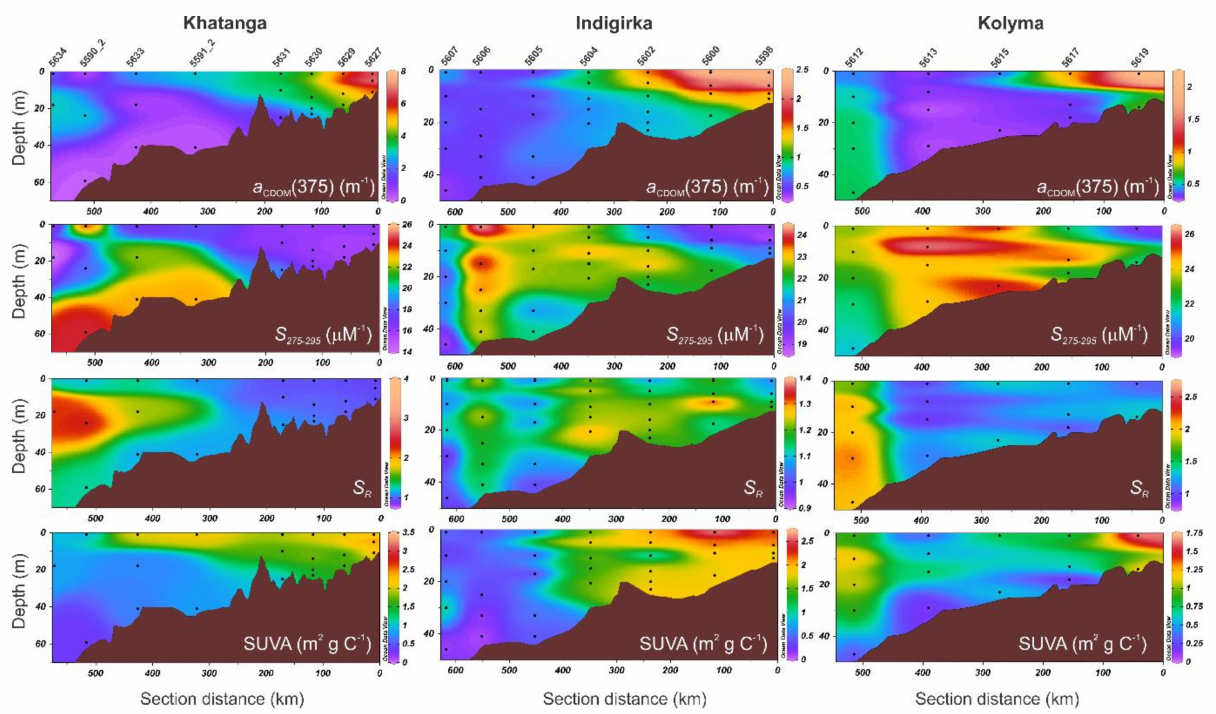
Figure 7. Distribution of a CDOM (375), S 275–295 , S R and SUVA along the Khatanga, Indigirka, and Kolyma